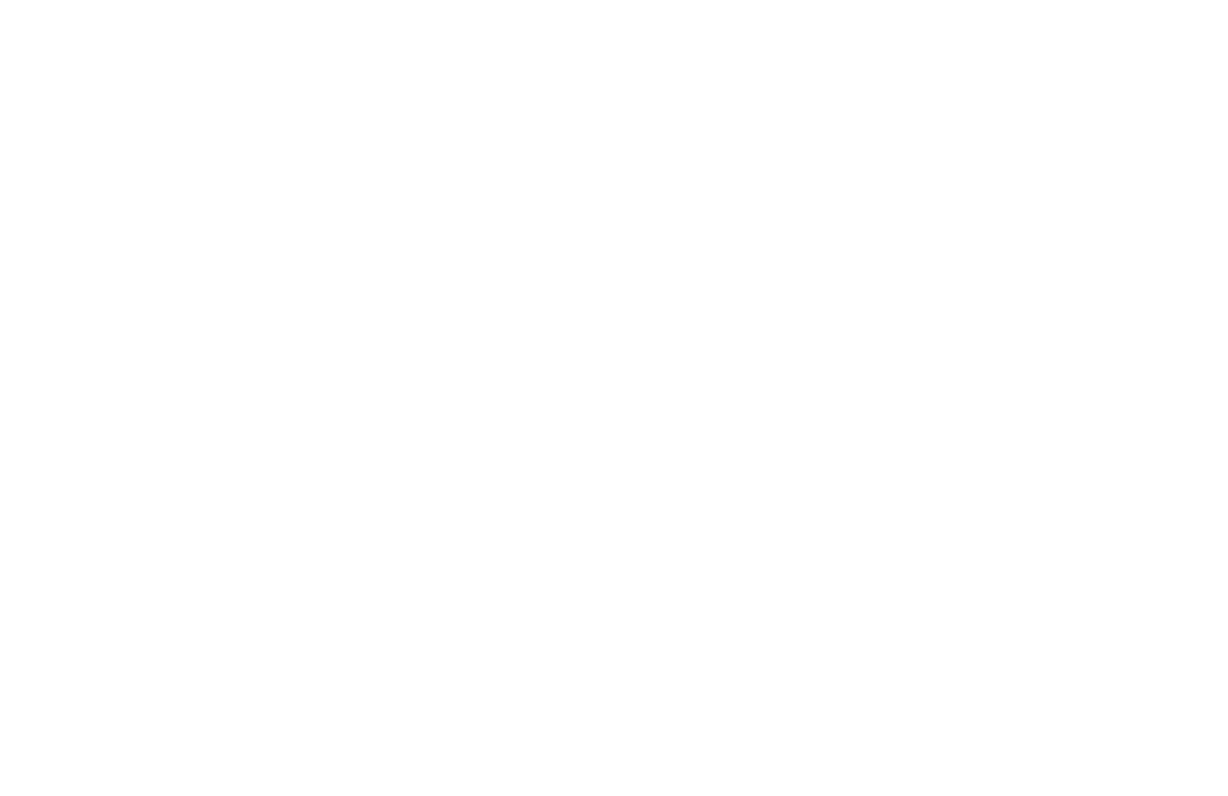
Frontiers in Robotics and AI | www.frontiersin.org